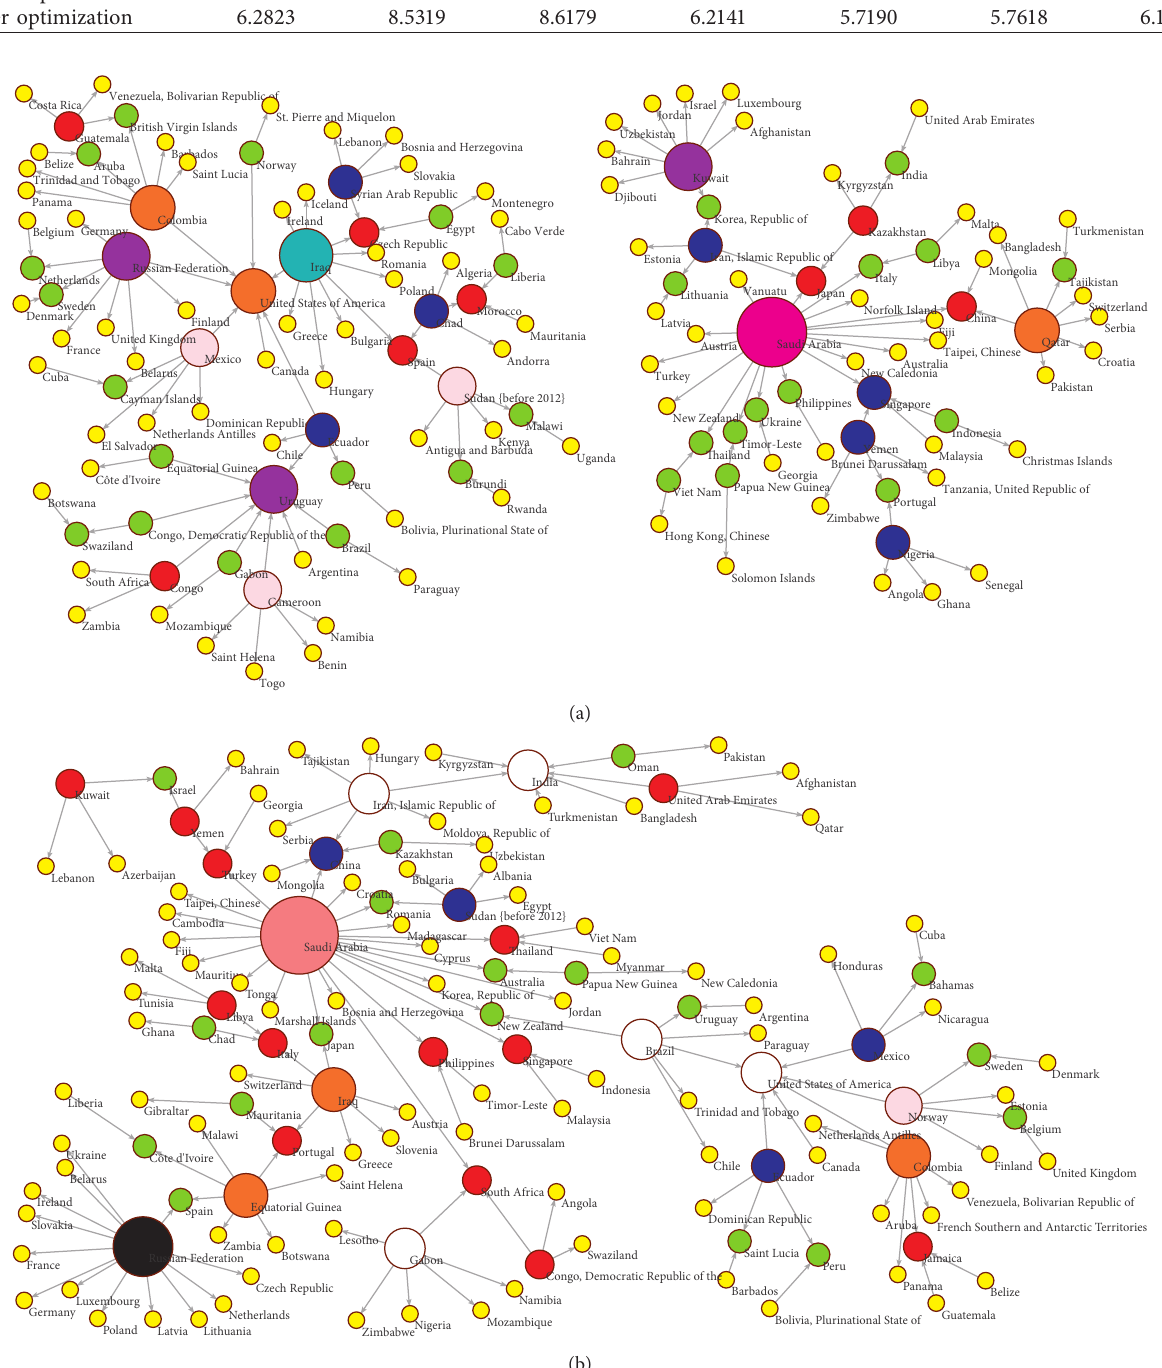
Figure 4: The optimal crude oil bipartite network structure: (a) 2010; (b)